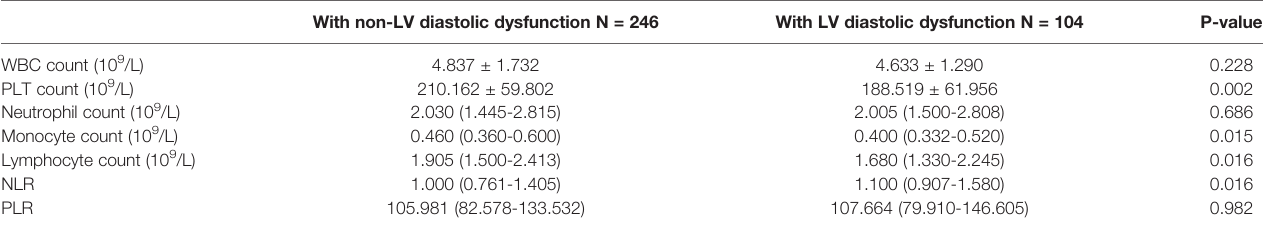
TABLE 2 | White blood cells-derived in fl ammatory parameters of the hyperthyroid patients with LV diastolic dysfunction.